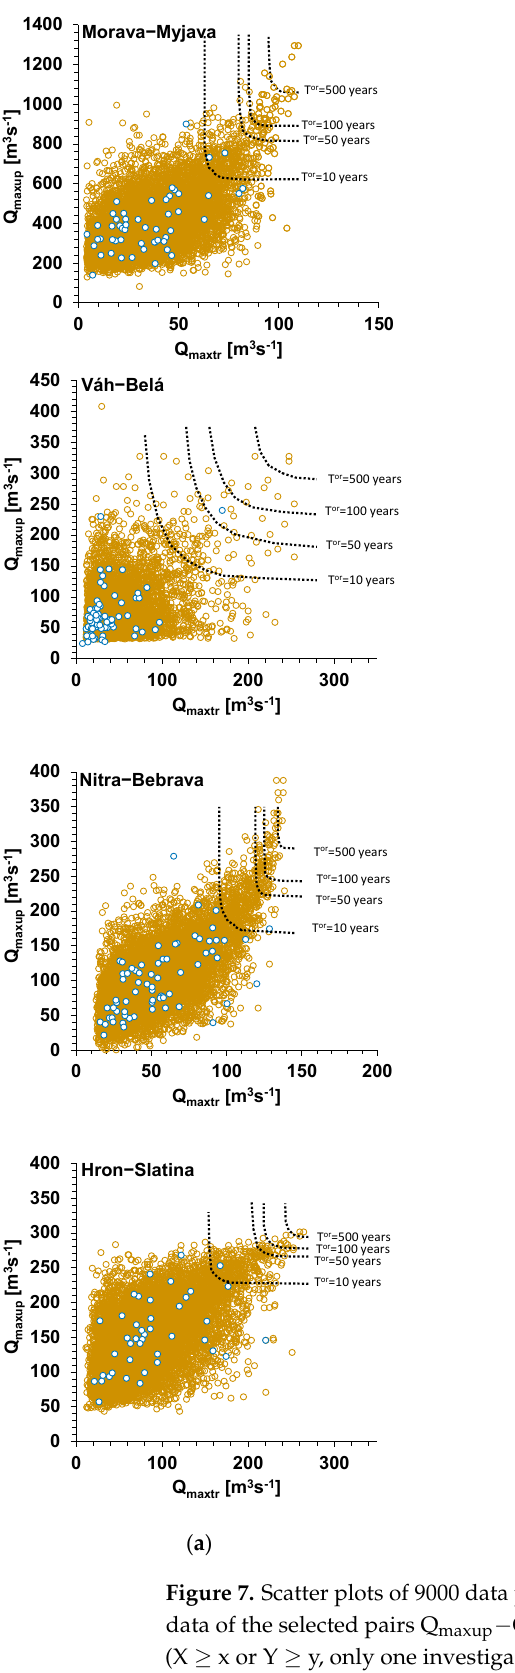
mainstreams and their tributaries). These extreme values represent the worst case scenario for flood hazards at these confluences. Table 5 presents a comparison of the estimated T- year designed discharges (Q 50 , Q 100 , Q 200 , Q 500 , and Q 1000 ) based on the univariate approach and the copula approach for gauging stations below the selected mainstream river confluences. For the traditional univariate method, the resulting discharge for the selected return period was calculated as a reciprocal of the probability of exceedance.